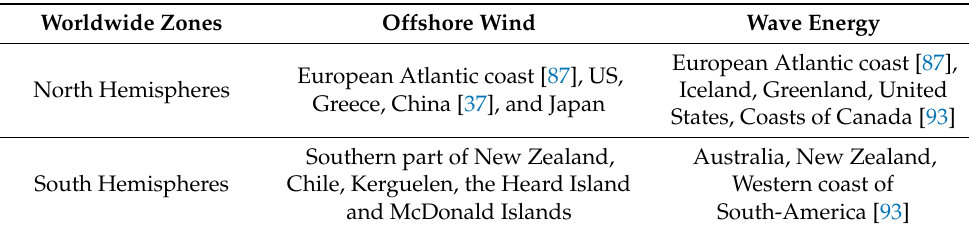
Table 3. The HOWWE distribution in the northern hemisphere’s degree (40 ◦ ) and in the southern hemisphere’s degree (60 ◦